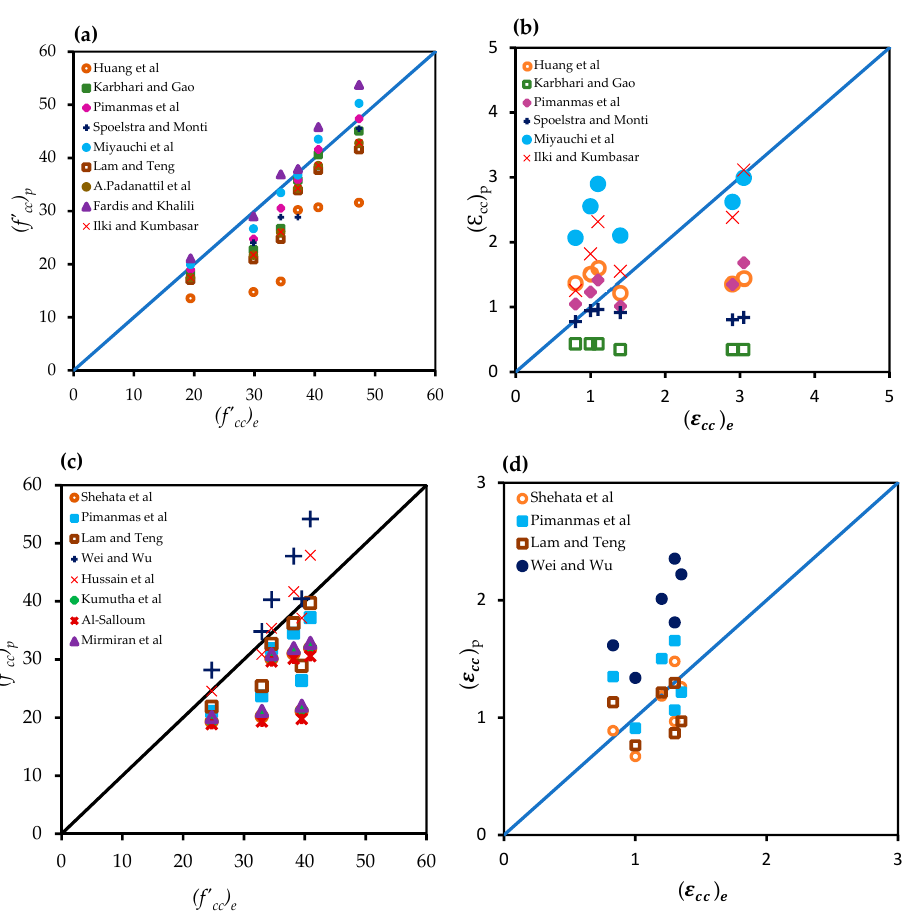
Figure 13. Performance of existing strength and strain models: ( a ) Strength models of circular specimens;